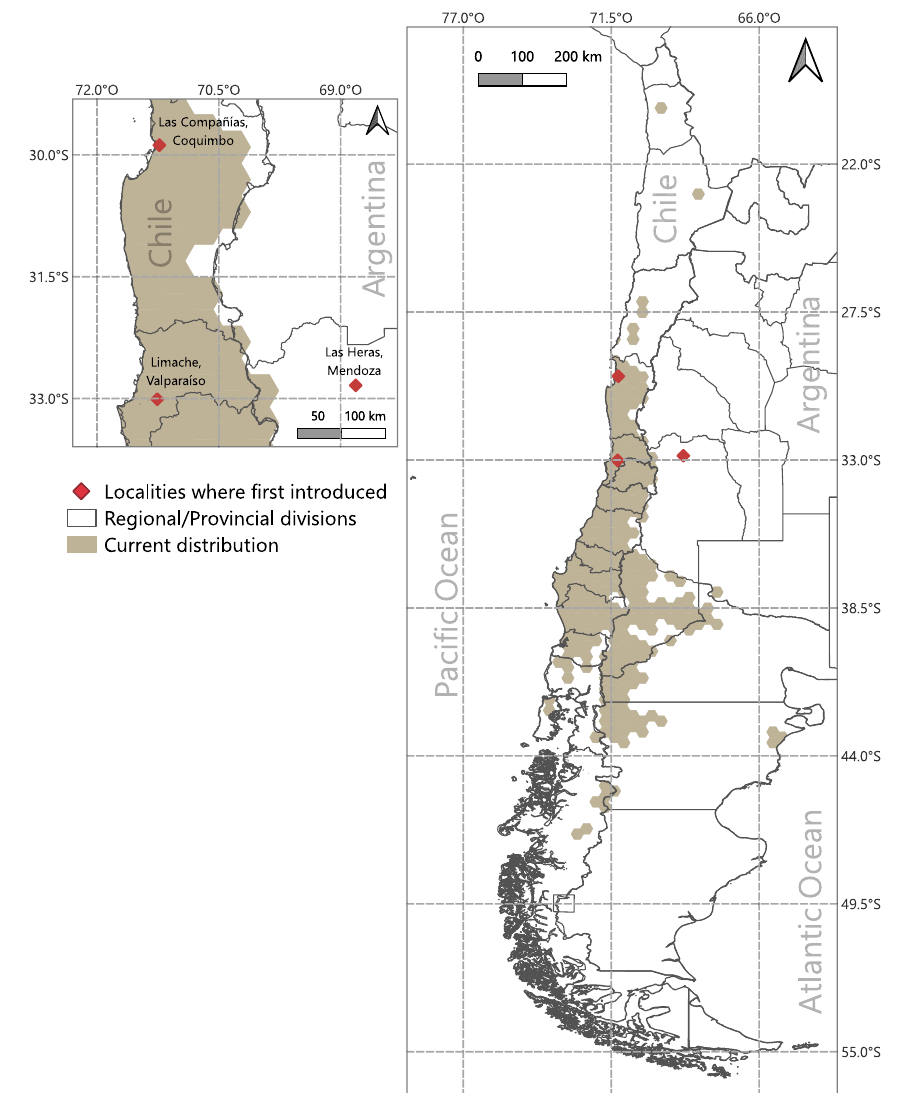
Fig. 1 Map of occurrence of California Quail in Regions of Chile and Provinces of Argentina, depicted in light